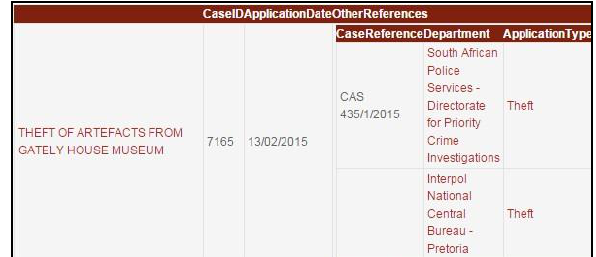
Figure 2: Example of police officer’s dashboard